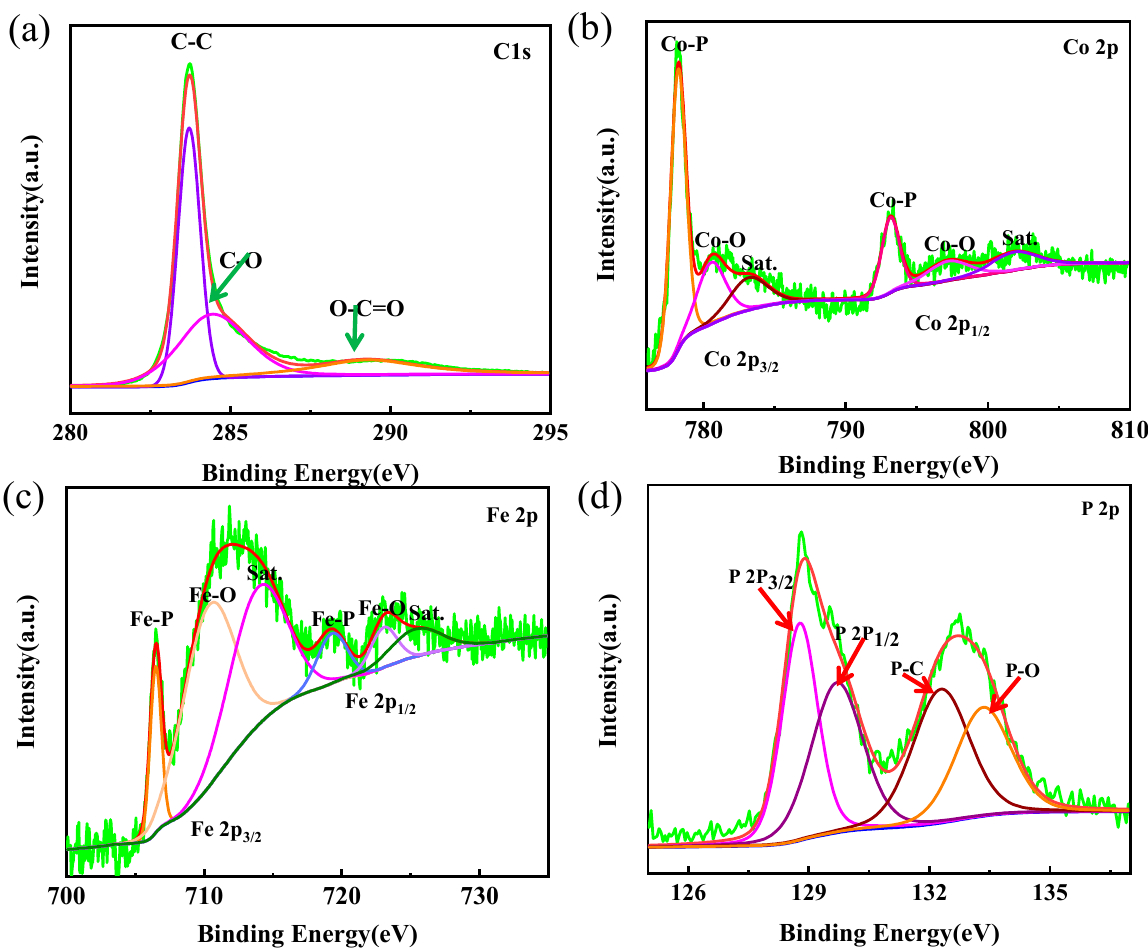
Figure 3. ( a – d ) The XPS spectra of ( a ) C 1s, ( b ) Co 2p, ( c ) Fe 2p and ( d ) P 2p of CoP/FeP 4 @CNT